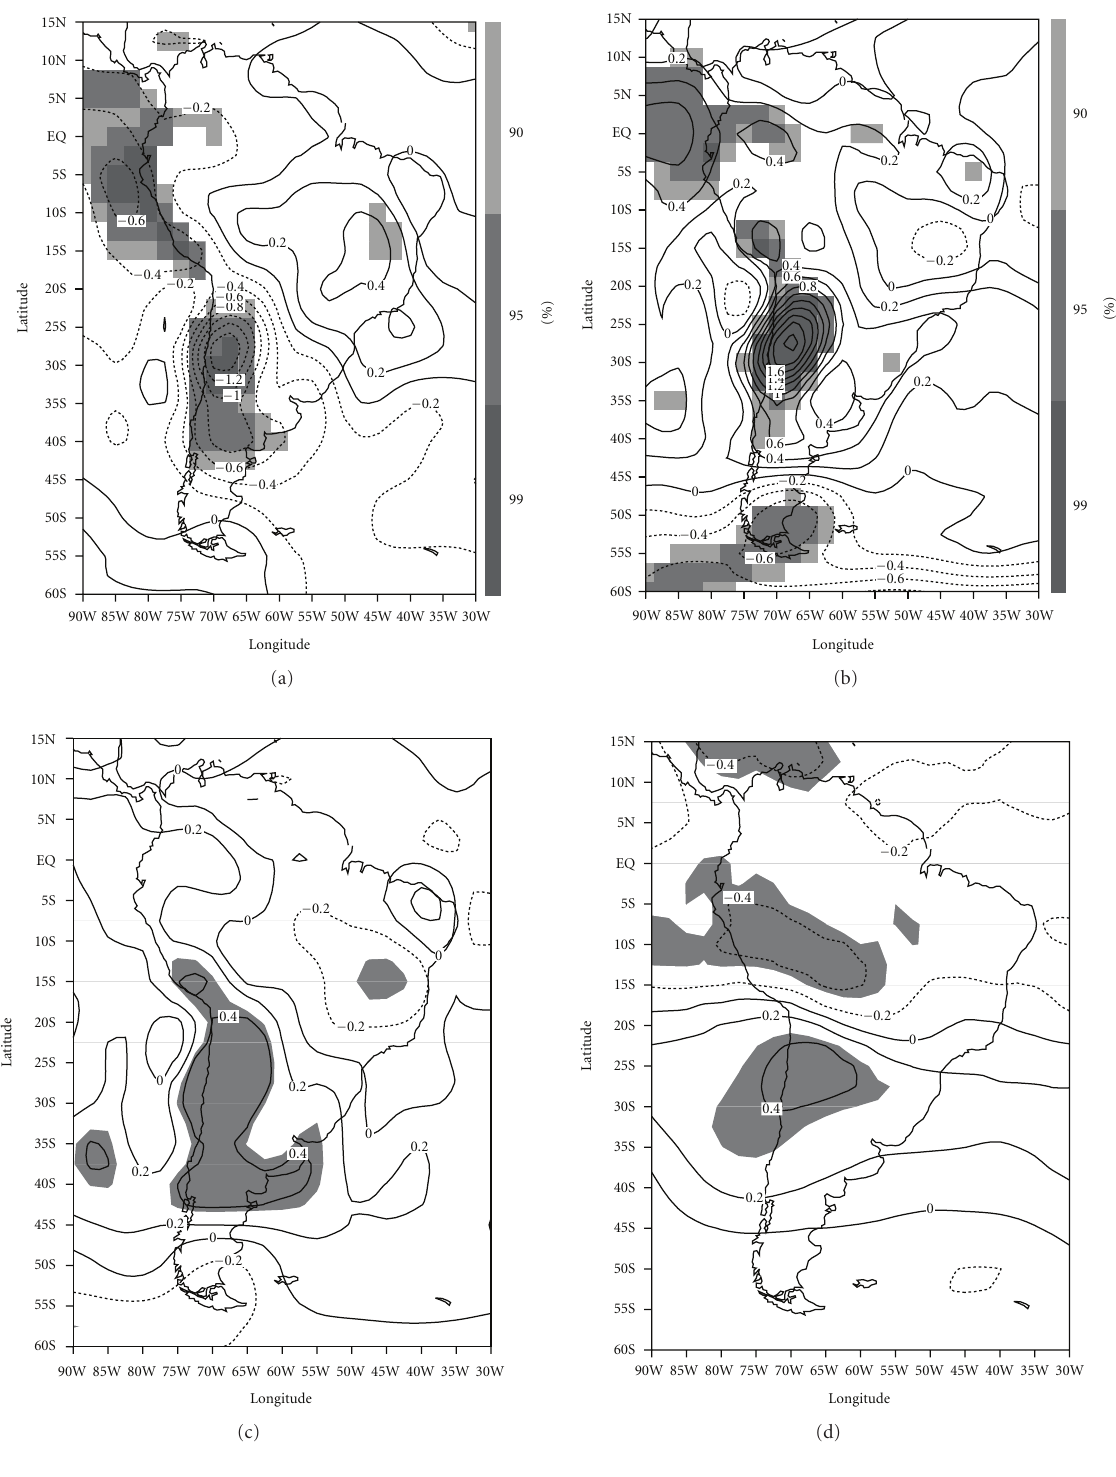
Figure 8: Air temperature (K) at 925 hPa in JJA for: (a) anomaly for weak HC cases, (b) anomaly for strong HC cases. Correlation between austral winter HCI and: (c) air temperature (K) at 925 hPa, (d) stationary wave geopotential height at 500 hPa. The contour interval is 0.2K in (a) and (b) and the statistically significant values at the 90%, 95%, and 99% levels according to a two-tailed Student’s t -test are shaded in grey scale (see vertical bar). The contour interval is 0.2 in (c) and (d), and regions exceeding 95% significance level ( > r = 0 . 349) are